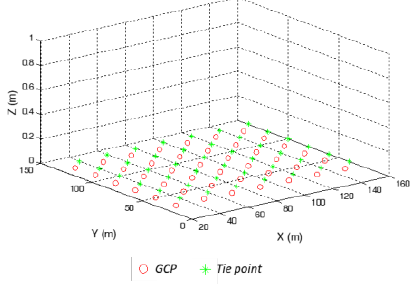
Figure 3. Simulated GCPs and tie points for the trials.